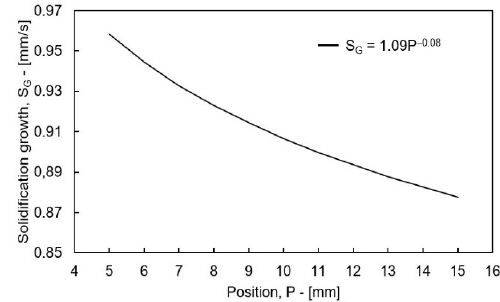
) as function of position ( P G